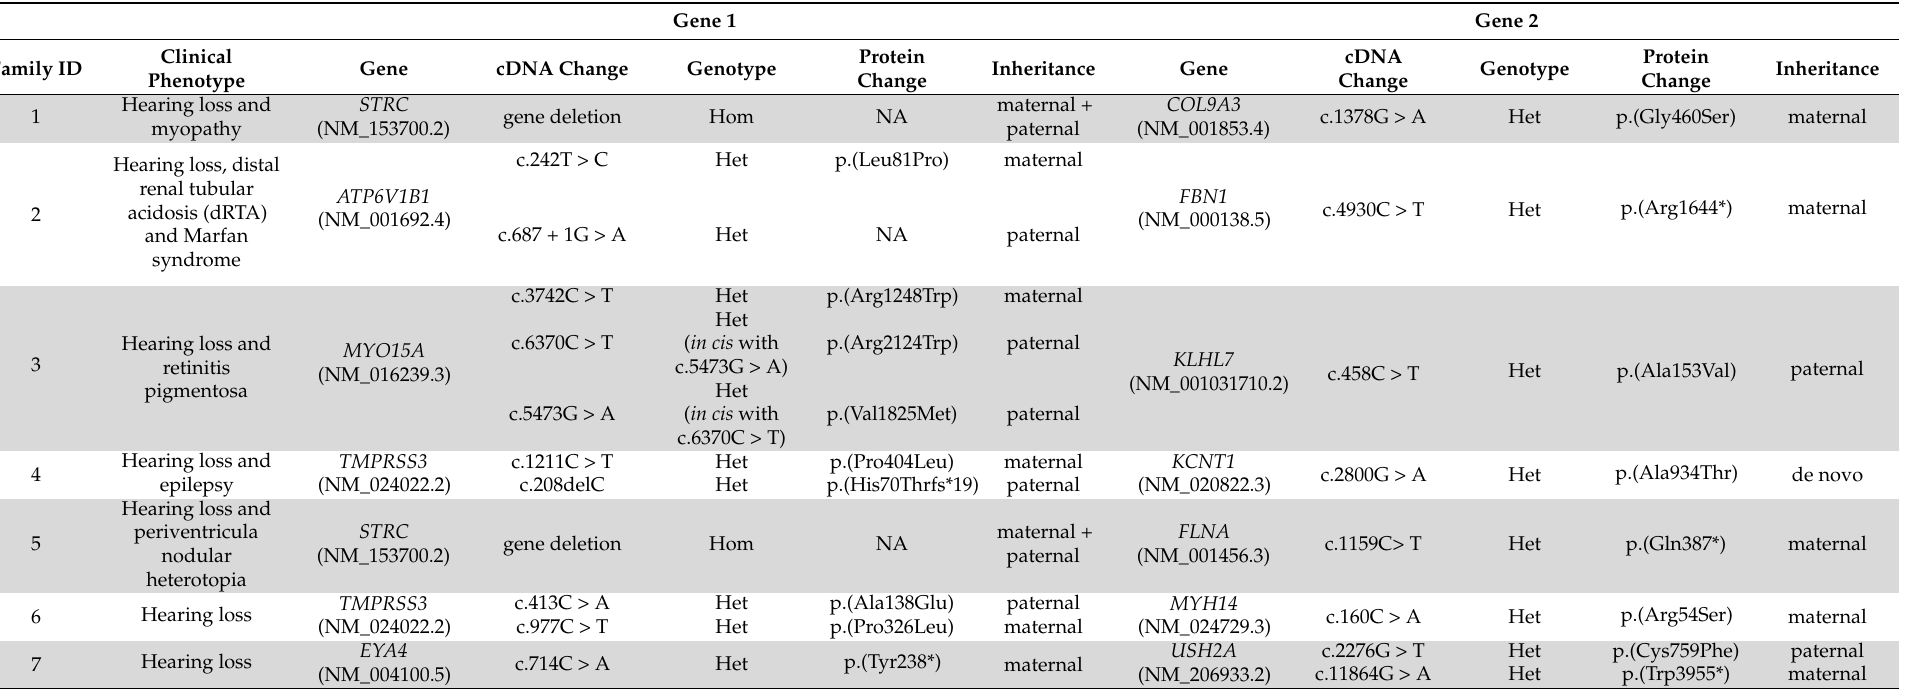
Table 1. List of dual molecular diagnoses identified by WES and MLPA. The table displays the main clinical features and the variants detected in the probands with a dual molecular diagnosis. Hom = homozygous; Het = heterozygous; NA = not available.The * symbol indicates a stop codon in the protein, according to the HGVS nomenclature